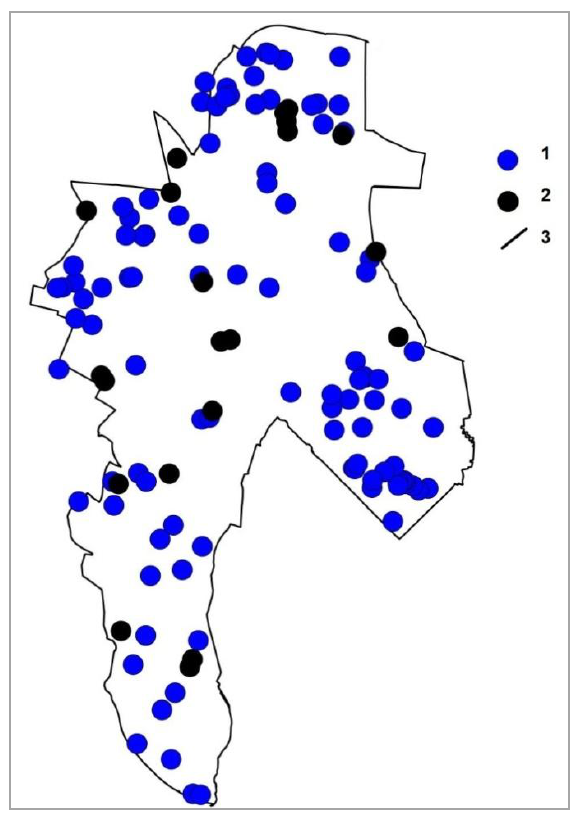
Fig. 6. Water reservoirs in